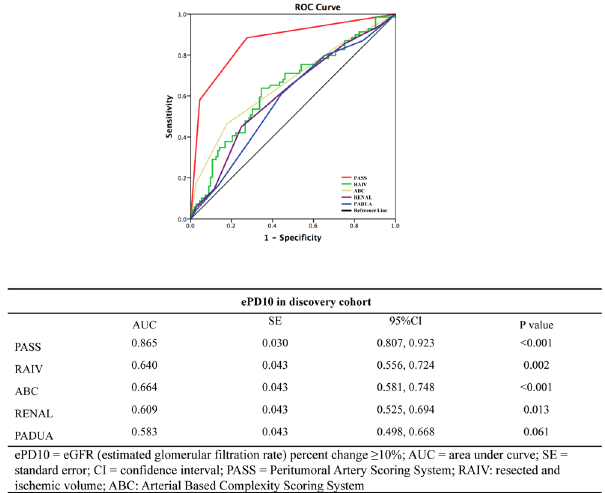
Figure 3. ROC curves for the prediction value of ePD10 between PASS and 4 nephrometry scoring systems in discovery cohort.